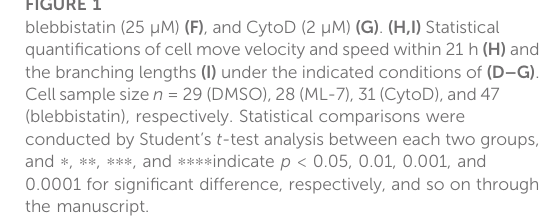
FIGURE 1 blebbistatin (25 μ M) (F) , and CytoD (2 μ M) (G) . (H,I) Statistical quanti fi cations of cell move velocity and speed within 21 h (H) and the branching lengths (I) under the indicated conditions of (D – G) . Cellsamplesize n =29(DMSO),28(ML-7), 31(CytoD), and47 (blebbistatin), respectively. Statistical comparisons were conducted by Student ’ s t- test analysis between each two groups, and p , pp , ppp , and pppp indicate p < 0.05, 0.01, 0.001, and 0.0001 for signi fi cant difference, respectively, and so on through the